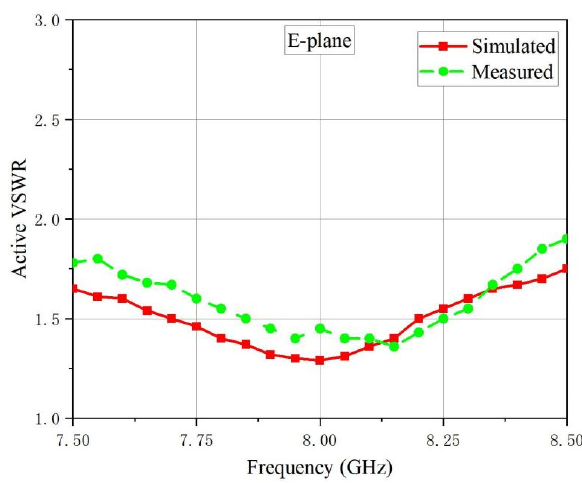
Figure 16. The active VSWR of the E ‐ plane.